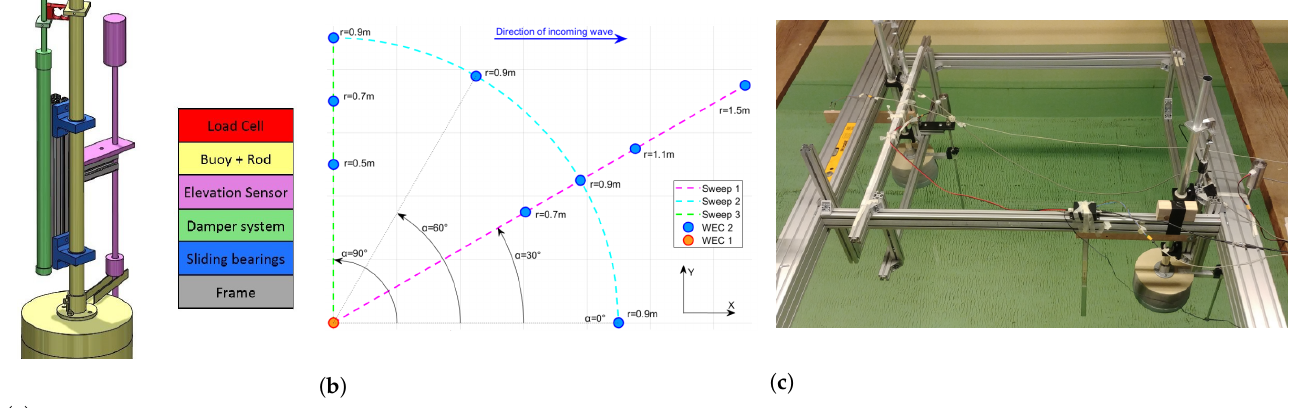
Figure 12. Experimental setup used by Boere et al., reprinted with permission from Ref. [42], 2018, Boere et al.: ( a ) WEC model; ( b ) tested WEC array configurations; ( c ) TU Delft’s towing tank setup